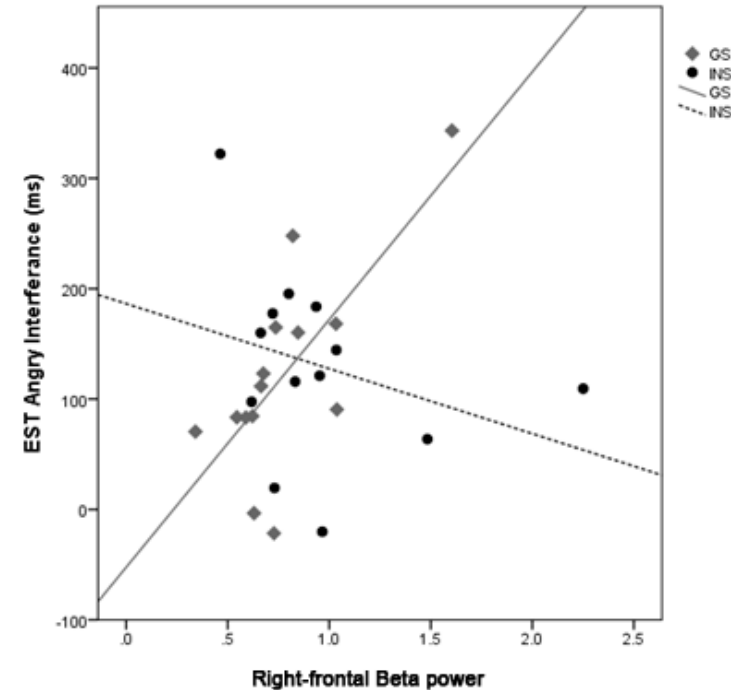
Figure 5. The correlations between right-frontal beta power and the interference effect for Angry trials on the Emotional-Stroop for GS and INS groups. A night of greater right-frontal beta power was associated with greater interference on Angry trials for the GS group.